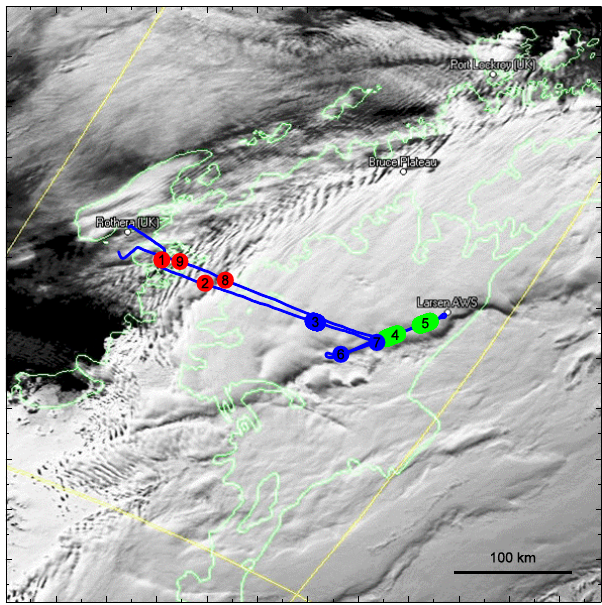
Fig. 2. AVHRR visible satellite image coincident with flight 104 (12 February 2010) showing the aircraft flight track. Positions of interest along the track are marked with numbered points, which are referred to in the text. The red markers denote regions of orographic cloud, the blue is stratified cloud over the Larsen Ice Shelf and green denotes Hallett Mossop temperature cloud.